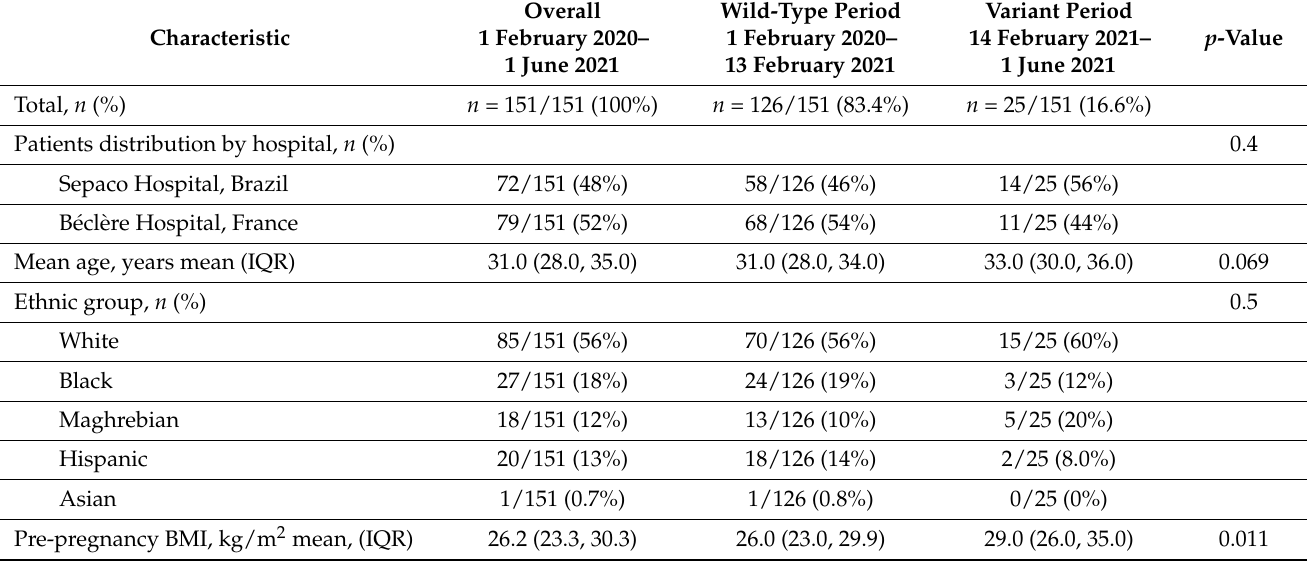
Table 1. Baseline characteristics of COVID-19 symptomatic pregnant women during “wild-type period” and “variant period”.